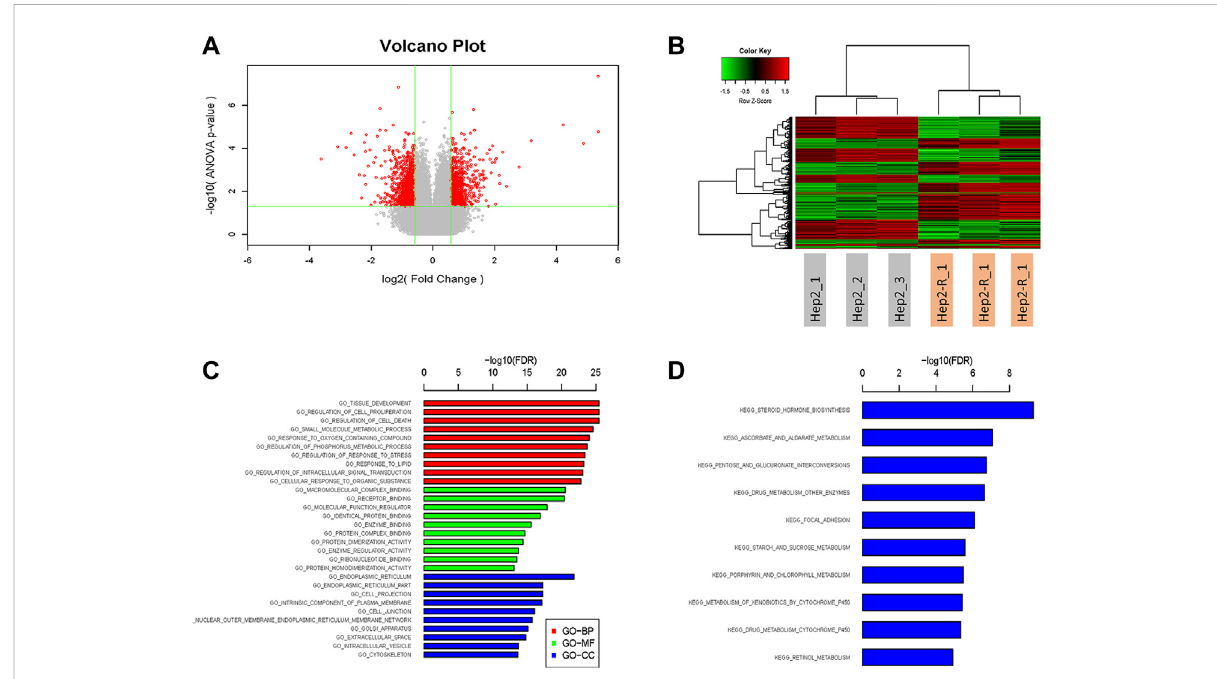
FIGURE 2 Volcano plot (A) , Hierarchical clustering (B) , GO analysis (C) and KEGG pathway analysis (D) of 2,360 differentially expressed